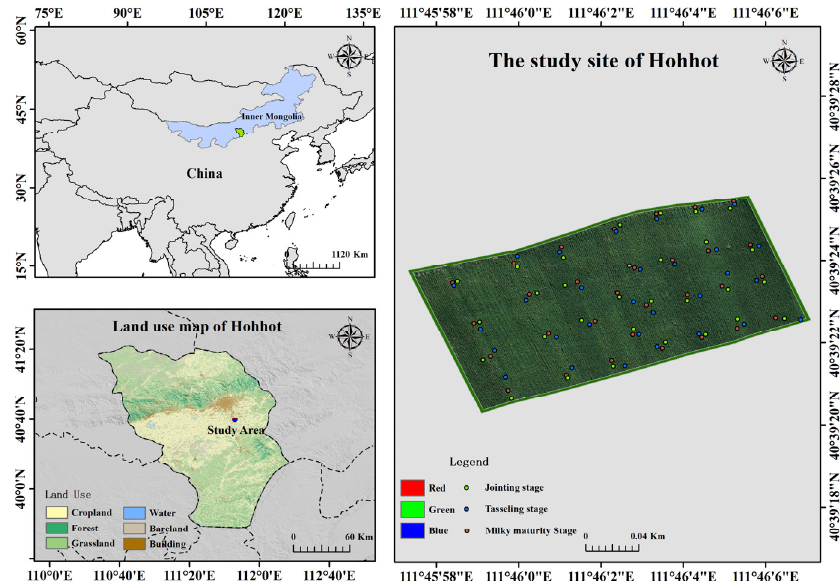
Figure 1. Location of the study sites.